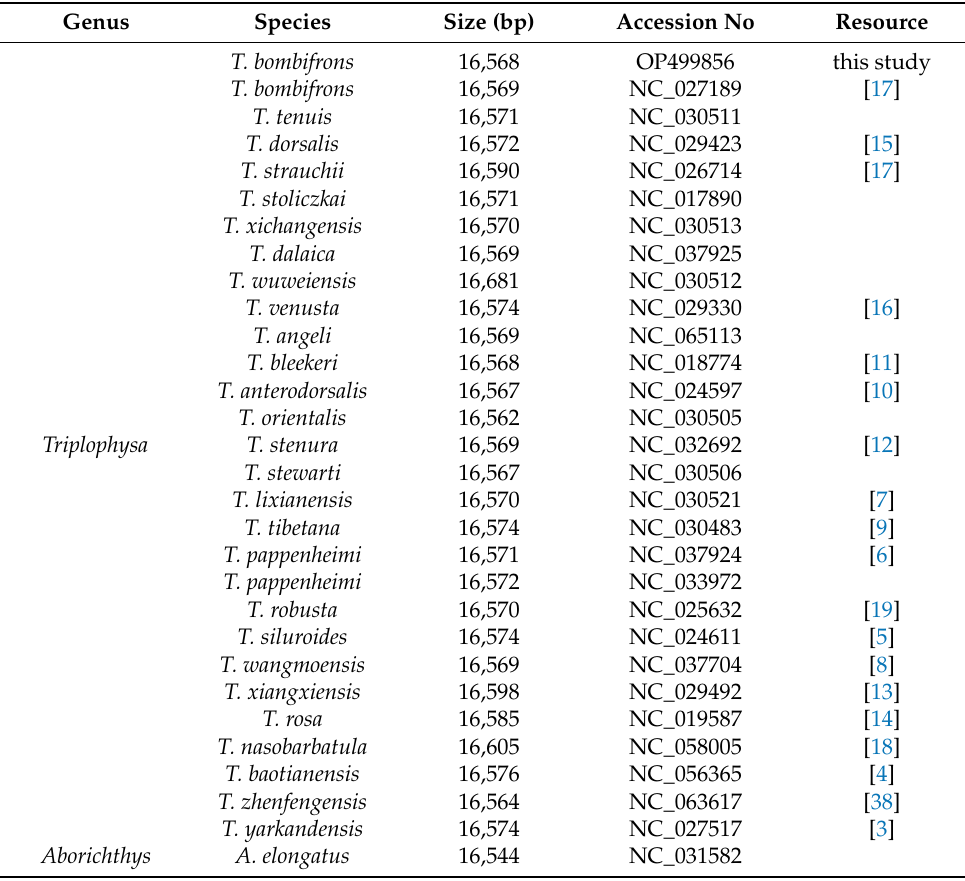
Table 1. Detailed information of the mitogenome sequences from 29 Triplophysa and 1 Aborichthys species in this study. Genus Species Size